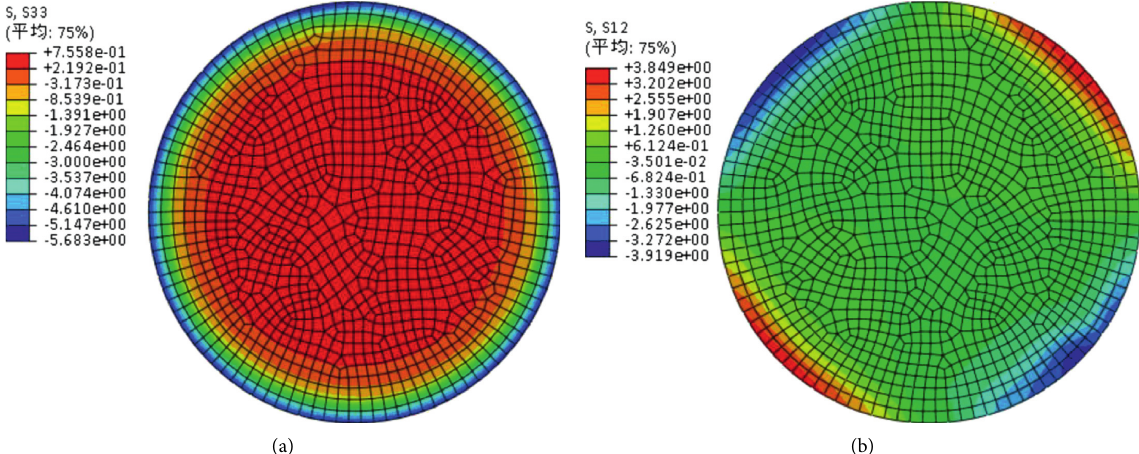
Figure 13: Hoop (S12) and axial stress (S33) distribution.